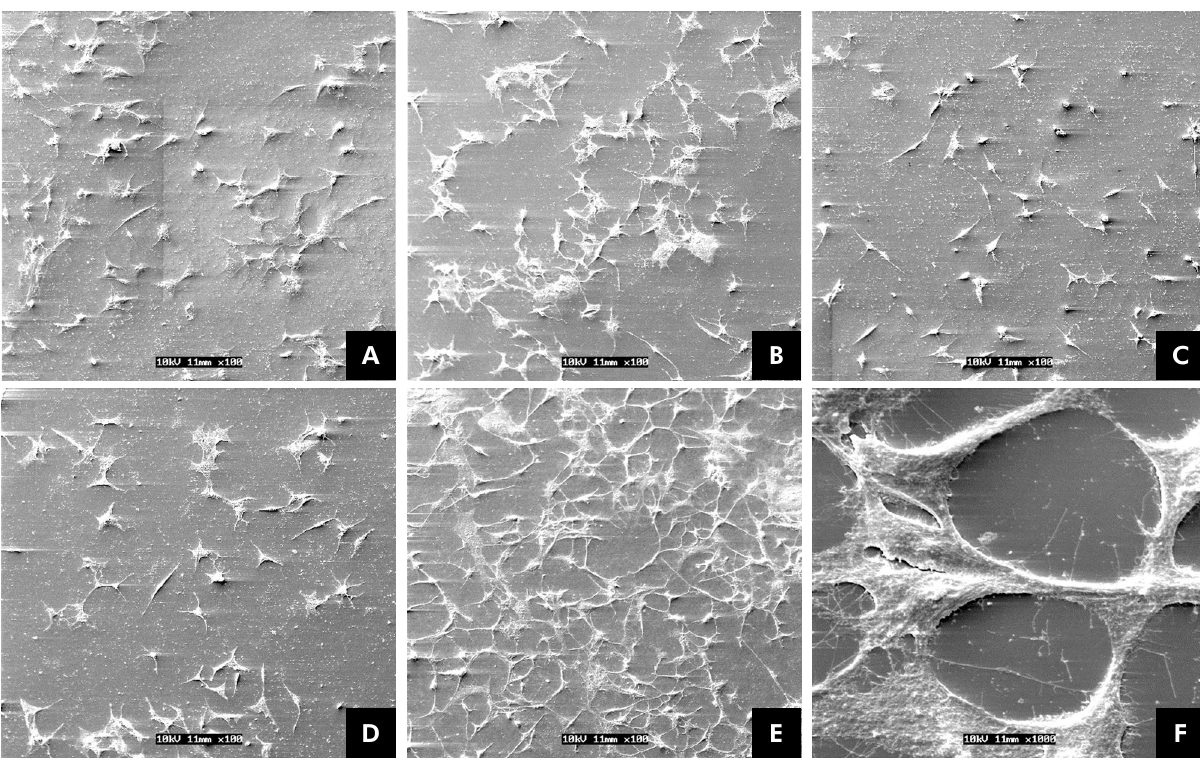
Figure. Representative SEM images of MDPL-20 cells exposed to the extracts from the experimental cements or the DMEM at 24-hour and 7-day periods. (A) White MTA: Only a few cells remained adhered to the glass substrate, in comparison with the negative control group, irrespective of the period of analysis. Note the typical morphology of fibroblasts - wide cytoplasm with several small cytoplasmic processes. (B) White CER: Significant decrease in the number of cells adhered to the glass substrate, in comparison with the negative control group. (C) Gray CER: Observe the similar morphology of cells exposed to the control extracts, despite the lower number of adhered cells. (D) Experimental White MTA: As found in the other experimental groups, a reduction was observed in the number of cells adhered to the glass substrate, in comparison with the negative control group, with no cell morphology alterations. (E) Negative control group: Note the greater number of cells adhered to the substrate than in the experimental groups. (F) High magnification of (A): the cells adhered to the glass exhibit long and slender cytoplasmic processes, typical of MDPL-20 fibroblasts, irrespective of the period of